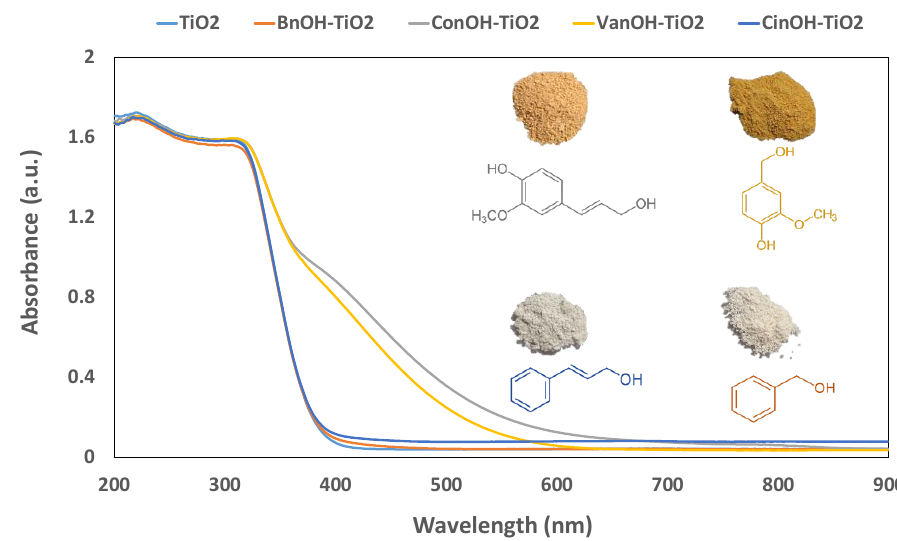
Figure 9. Visible light (515 nm) activity of other aromatic alcohols with bimetallic CuA-Au/TiO 2 in the batch system.